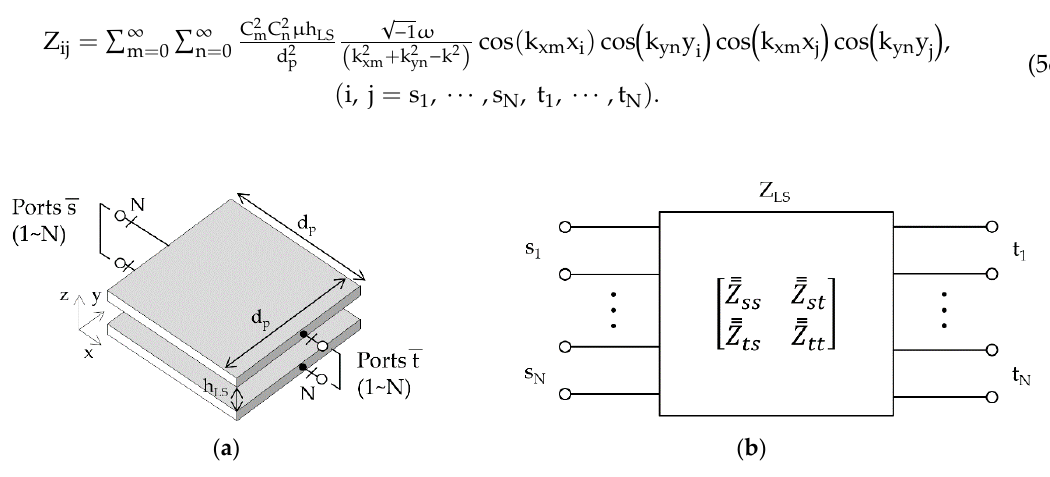
Figure 8. ( a ) Ports and design parameters; ( b ) the Z-matrix (Z LS ) of the low-Z o segment.